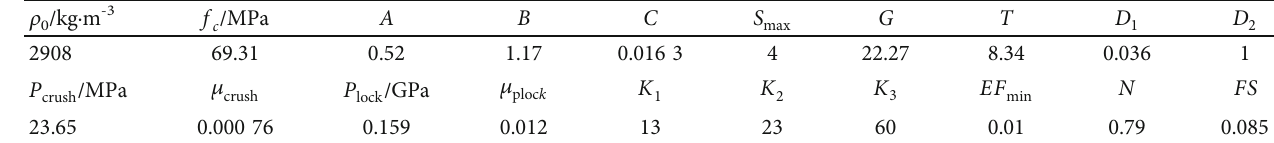
Table 4: Marble HJC constitutive model parameters.